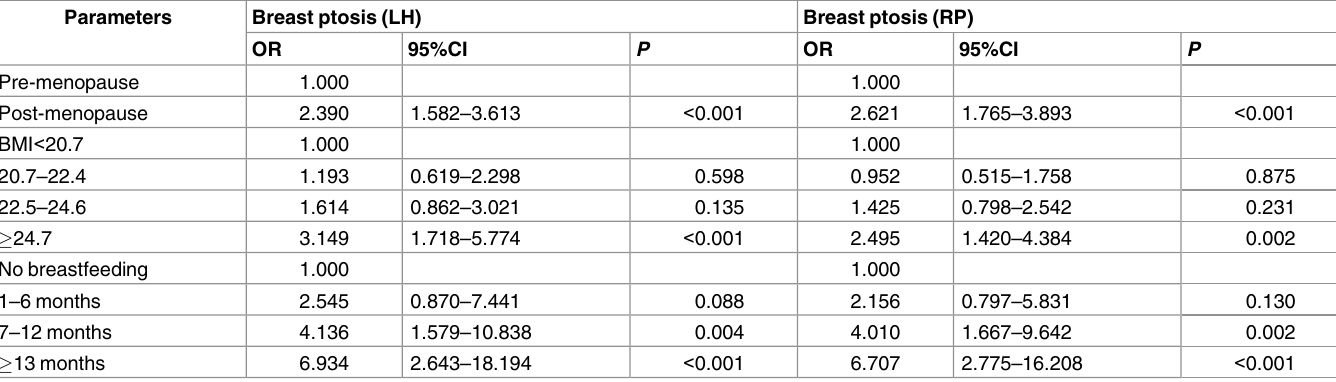
Table 4. Multivariate ordinal logistic regression analysis for breast ptosis using LH and RP